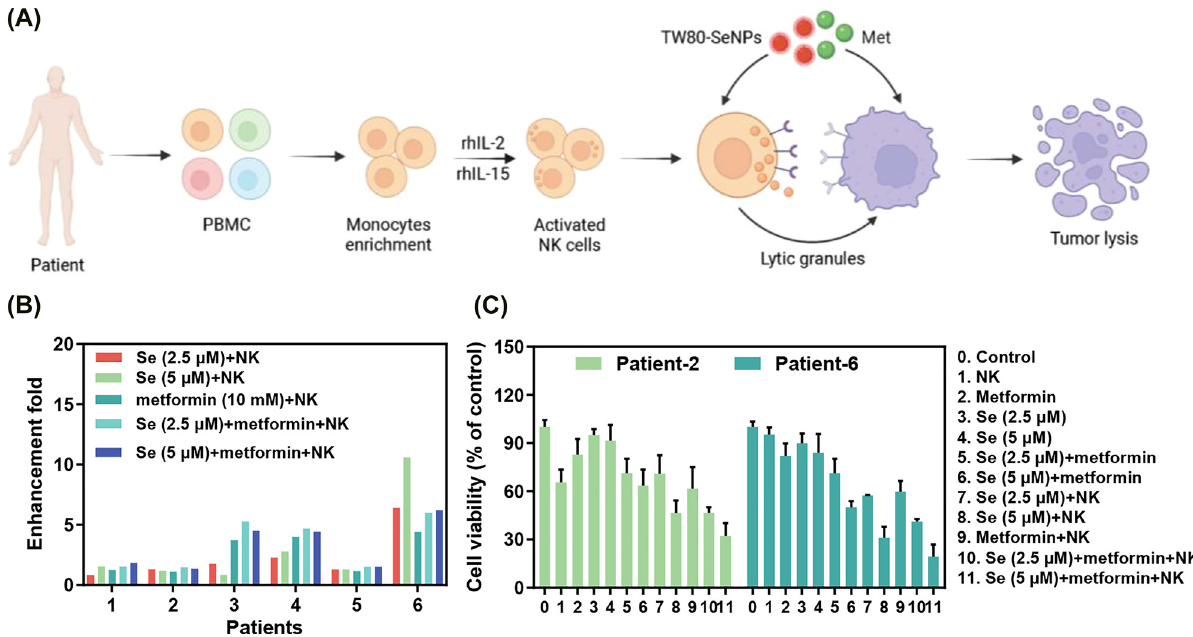
Figure 2: The enhancement fold changes of the combined treatment were calculated as the cancer cell growth inhibitory ratio percentage of NK cells